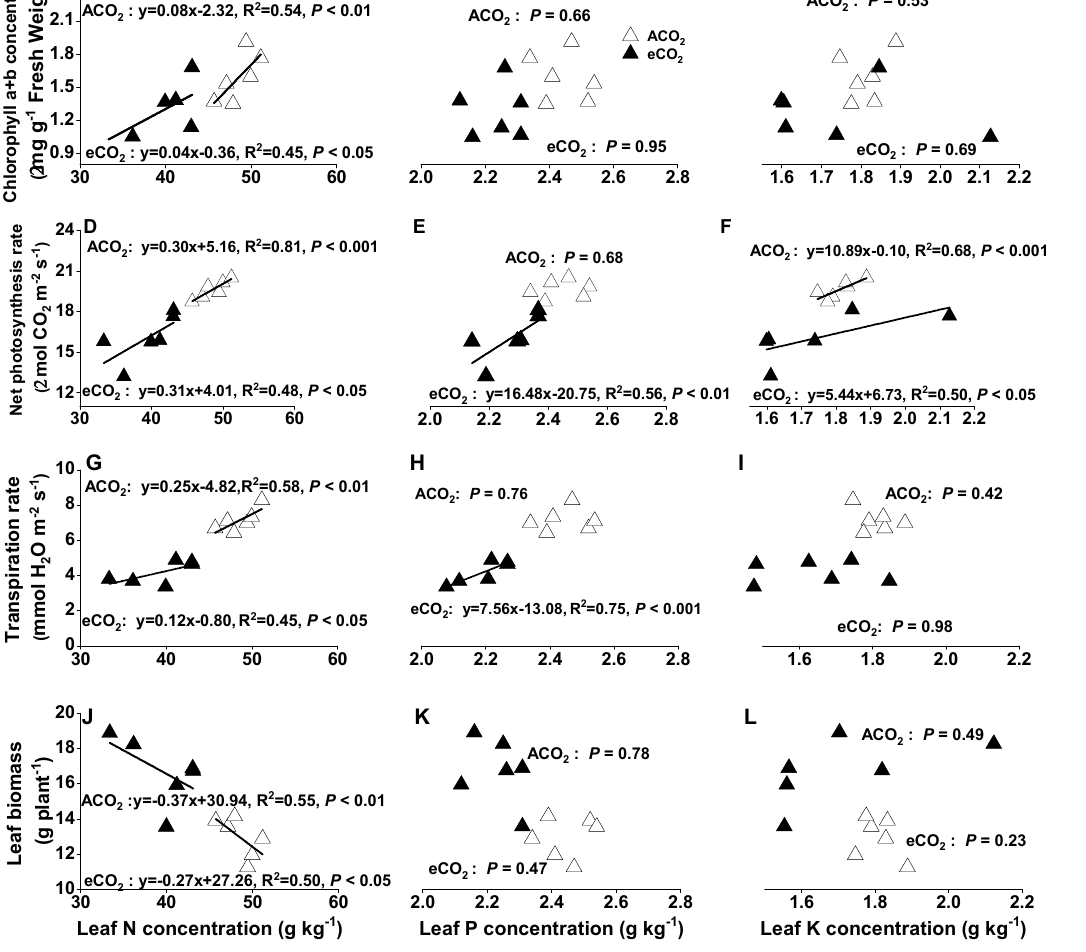
Figure 6. Relationships between chlorophyll a+b concentration and leaf nitrogen (N), phosphorus (P) and potassium (K) concentrations ( A – C ); net photosynthetic rate and leaf N, P and K concentrations ( D – F ); transpiration rate and leaf N, P and K concentrations ( G – I ); leaf biomass and leaf N, P and K concentrations ( J – L ). Linear regressions were fitted to data for two mulberry varieties ( Morus multicaulis Perr. var. QiangSang and NongSang) grown under ambient CO 2 (ACO 2 , 410/460 ppm, daytime/nighttime) and elevated CO 2 (eCO 2 , 710/760 ppm) levels. Open triangles and closed triangles represent data under ACO 2 and eCO 2 , respectively.